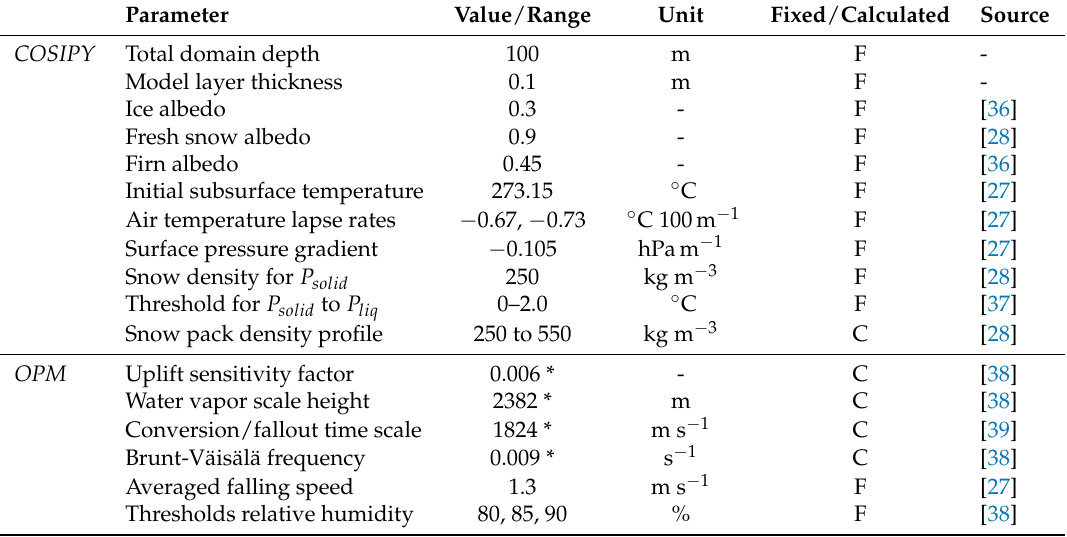
Table 1. COSIPY and OPM parameter settings based on findings from [27]. Values denoted with * are mean